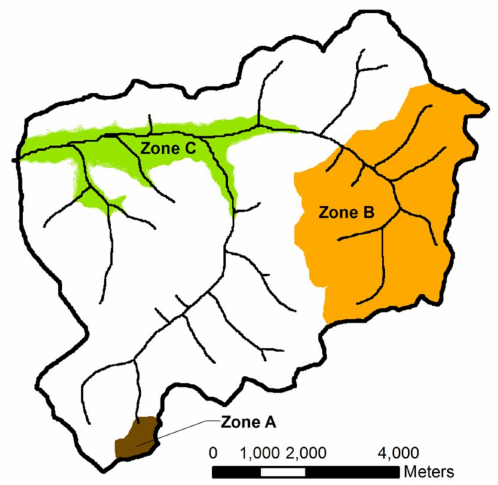
Figure 9. Three types of areas with various topographic conditions adopted for the time step